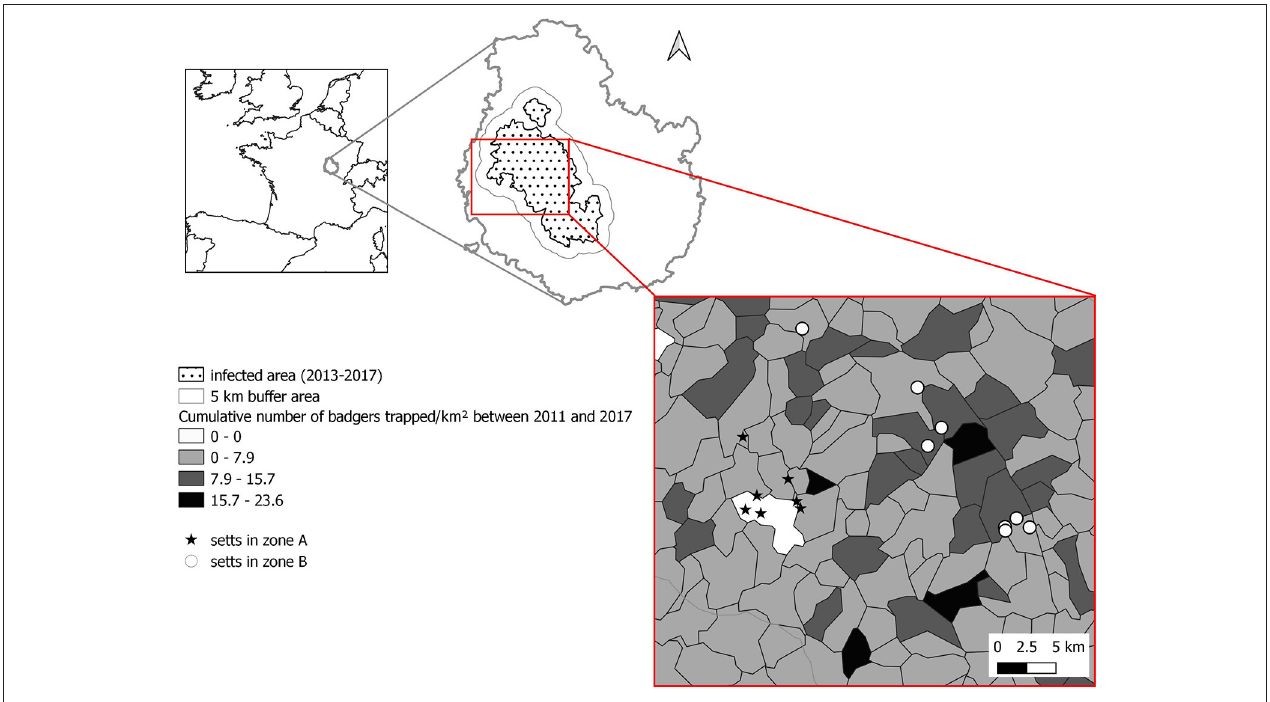
FIGURE 1 | Location of the setts selected within the study